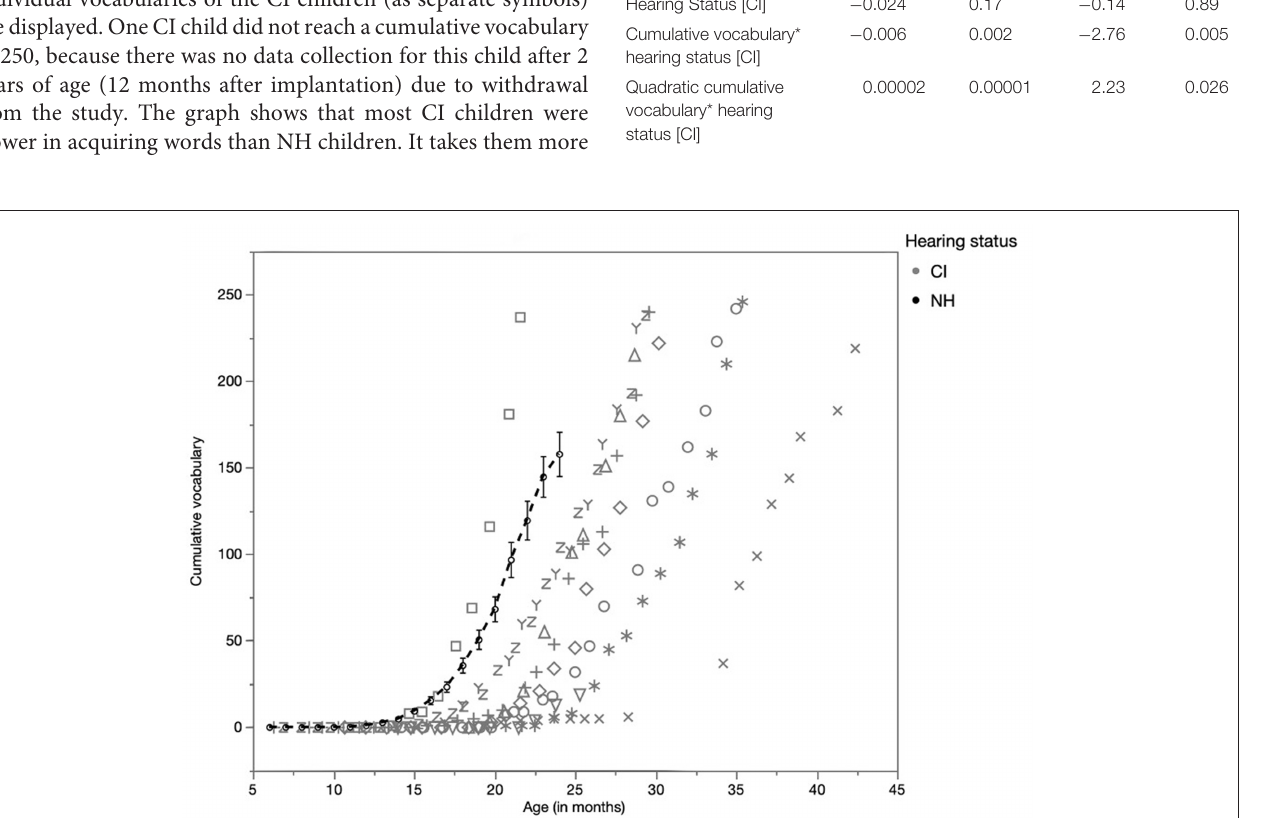
FIGURE 1 | Development of cumulative vocabulary of the NH children and the individual CI